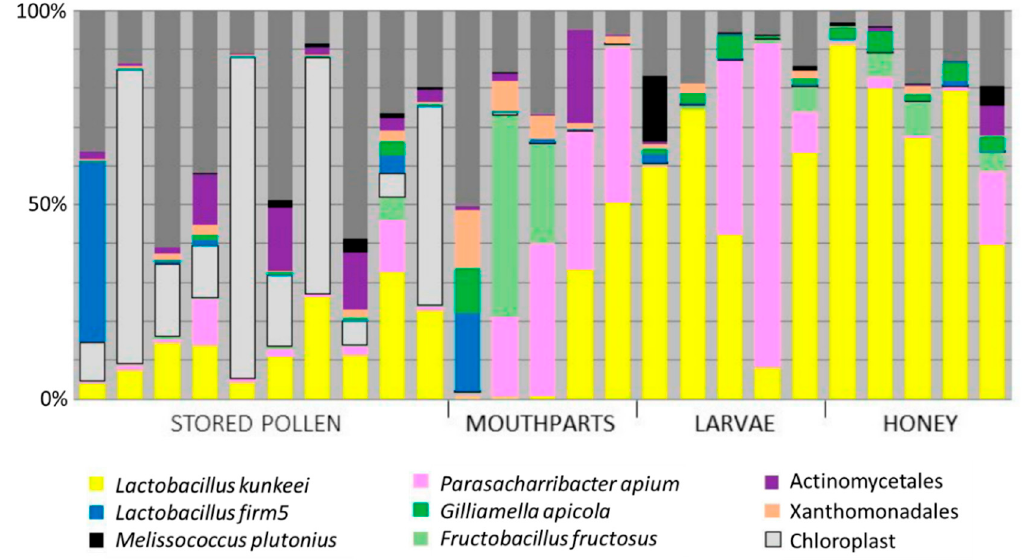
Figure 1. Bacterial communities associated with potential hive refugia (food storage) and transmission from adult mouthparts to larvae. We sequenced the 16S rRNA gene from four niches associated with larval feeding (see methods). Colors represent various bacterial species, genera or broad groups. The chosen primer set (V1–V3 region) also amplifies chloroplast genes from pollen (light grey). Dark grey represents the relative proportion of bacterial groups not listed in the figure legend (see Table S1).